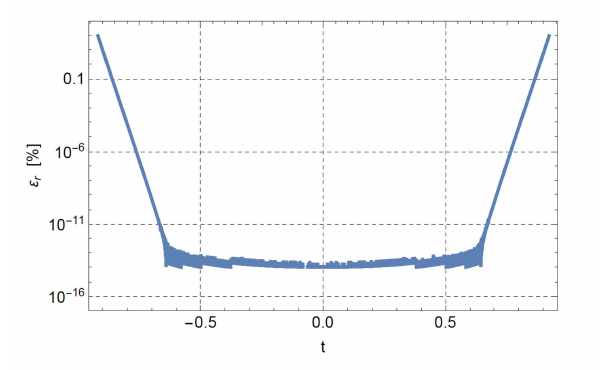
Figure 11. Relative percentage error of the Bell’s approximation of F ( t ) in